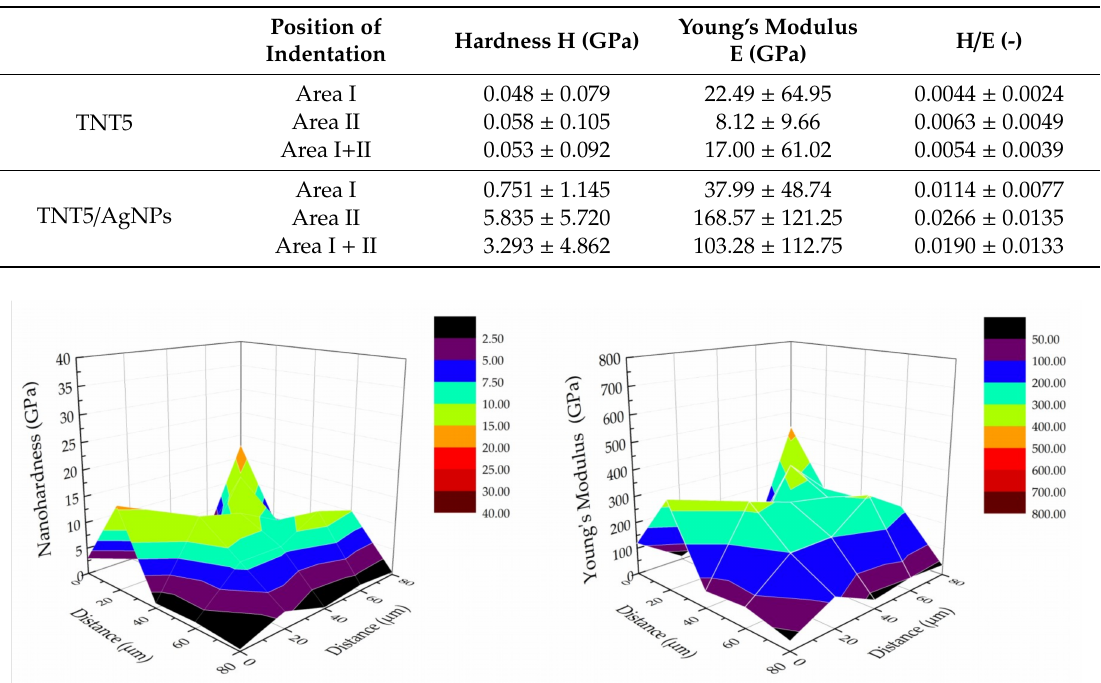
Figure 11. The nanomechanical properties (nanohardness and Young’s modulus) of TNT5 / Ag implant in the studied area